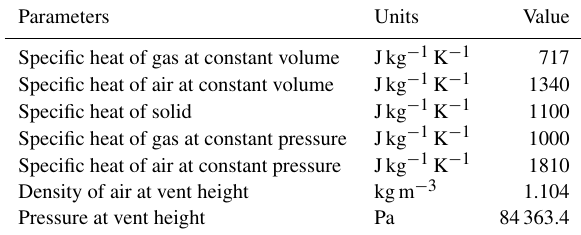
Table 3. List of material